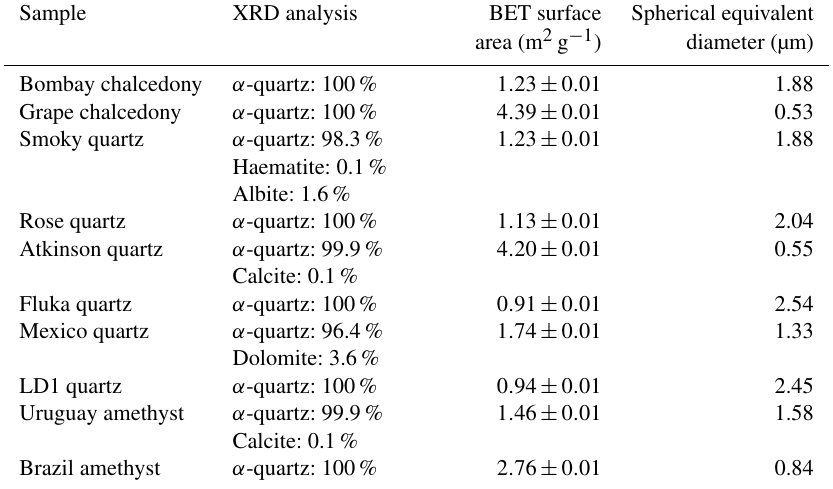
Table 1. Table showing the relative concentrations of different minerals within each sample and the respective BET-specific surface area of the ground sample and derived spherical equivalent average surface area. The uncertainty in the XRD analysis is on the order of 0.1%; therefore, the identification of some trace constituents in some samples is tentative. The mineral density was assumed to be 2.6gcm − 3 for the calculation of spherical equivalent